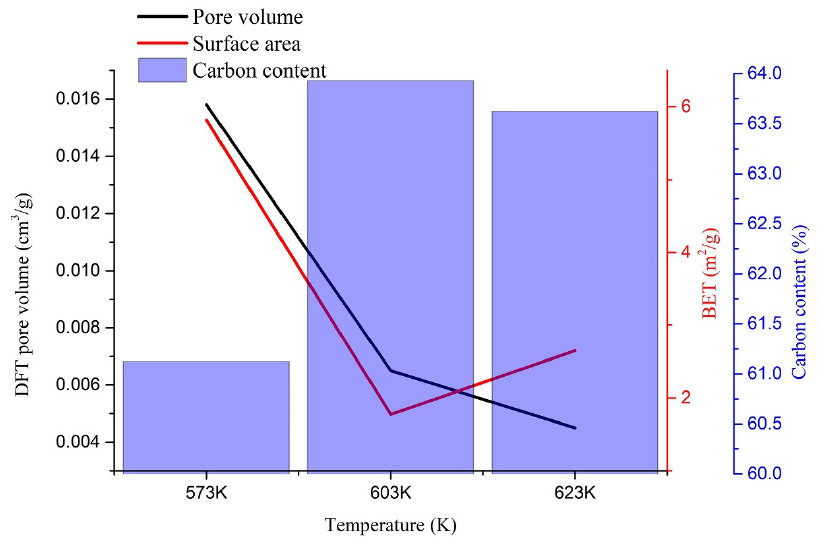
Figure 8. Relationship of carbon content surface area and the pore volume.